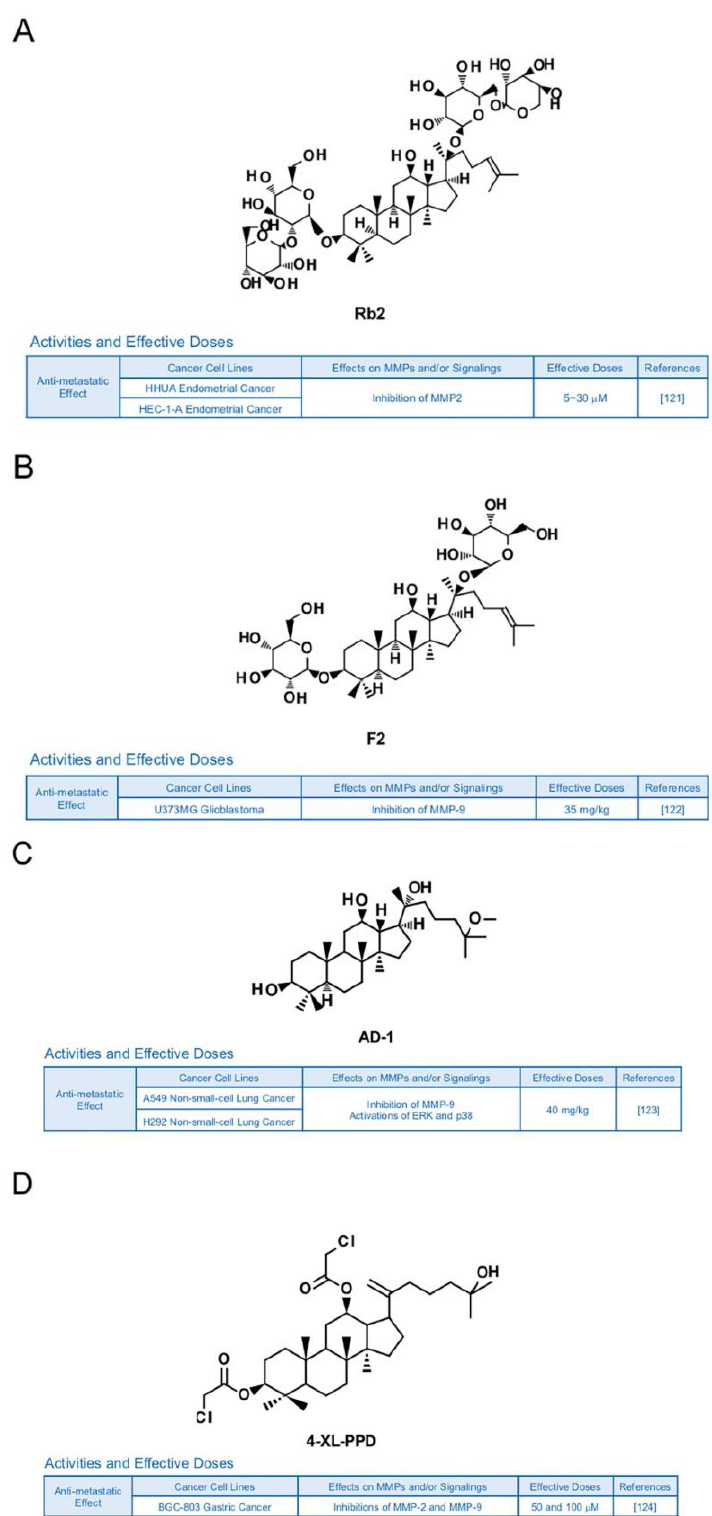
Figure 10. Summary of activities of ginsenosides Rb2, F2, AD-1 and 4-XL-PPD. Structures of Rb2 ( A ), F2 ( B ), AD-1( C ) and 4-XL-PPD ( D ) and their effects on MMPs and/or signalings [121–124]. Treatment with ginsenoside Rg5, one of main components in steamed ginseng, de- creased LPS-induced transcription of MMP-9 in BV2 microglial cells (30 and 50 µ M), which implies a neuroprotective potential [125] (Figure 11A). Ginsenoside Rb3 also hindered expression of gelatinases by down-regulation of JNK/NF-кB signaling axis in H9c2 murine cardiac myoblasts which were exposed to oxygen and glucose deprivation [126] (Figure 11B). Ginsenoside Ro, an oleanolic acid type-ginsenoside, inhibited inflammation and protein levels of MMP-3 and MMP-9 through inactivation of NF-кB in IL-1β-stimu- lated rat chondrocytes [127] (Figure 11C). Additionally, ginsenoside F4 (30 and 50 μM) diminished MMP-13 expression in IL-1β-stimulated SW1353 cells through inactivation of p38 [88] (Figure 11D).